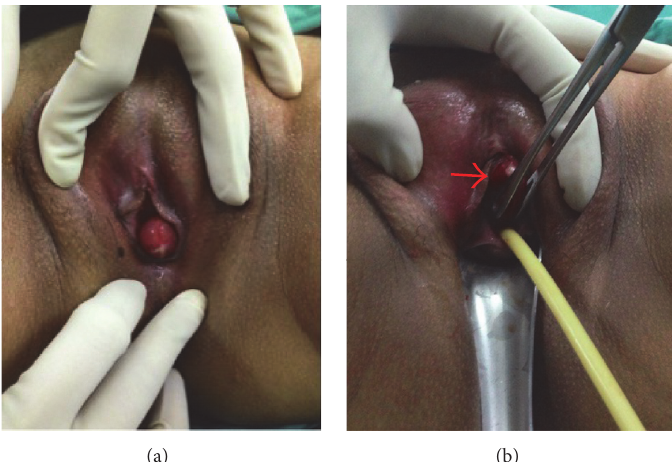
Figure 1: (a) A firm mass measuring 2.0 × 1.5 × 1.5cm on the urethral meatus and (b) its relationship with the urethral meatus (arrow indicates the urethral mass).